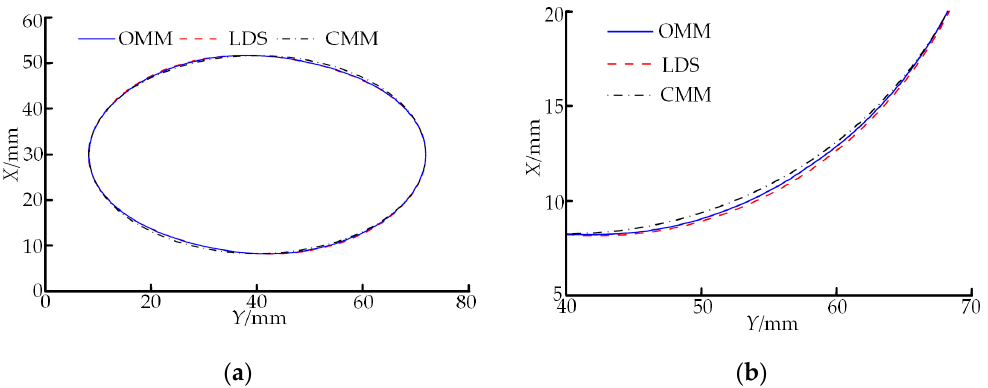
Figure 14. Comparison of measuring results of three methods . ( a ) Overall graph of measuring results; ( b ) locally amplified graph of measuring results.